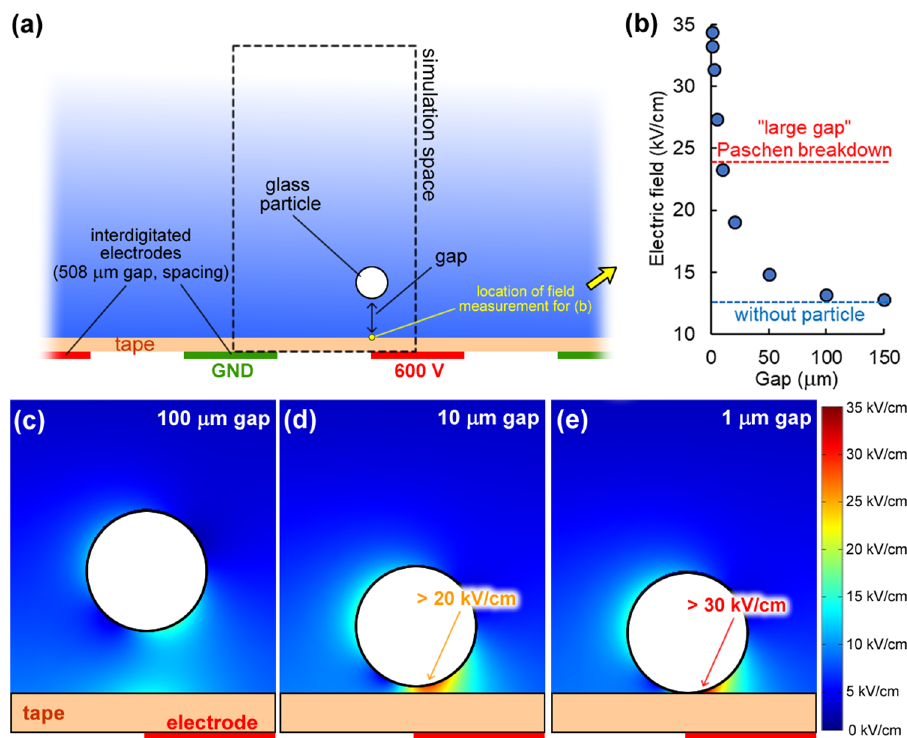
Figure 5. ( a ) Depiction of the simulation space (more details in Supplementary Material). ( b ) Magnitude of electric field at the indicated measurement point. As the gap decreases the localized electric field increases. ( c ) Numerical simulation result of the electric field magnitude near the particle for a gap of 100 µm; similarly for ( d ) 10 µm and ( e ) 1 µm gaps.